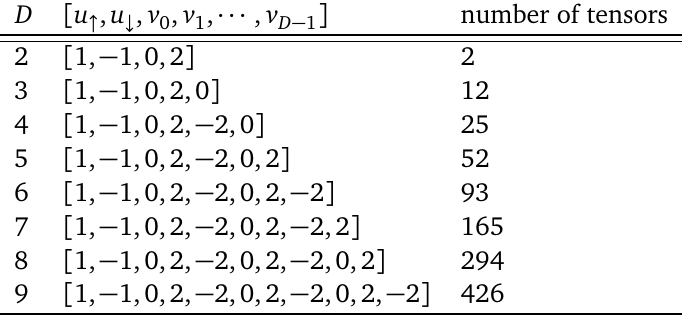
Table 1: U ( 1 ) charges as inferred from unrestricted simulations with bond dimen- sions D = 2,...,7. Predictions of the charges for D = 8 and 9 are also shown. Note that the ordering of the v α charges is arbitrary and the gauge freedom has been fixed by taking N = 1. The last column shows the number of elementary tensors t